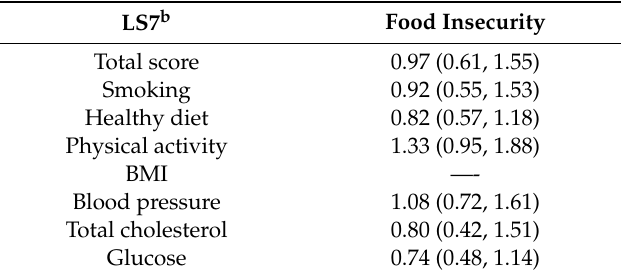
Table 4. Adjusted Odds Ratios (AORs) a and 95% Confidence Intervals (CI) of LS7 and Components by Food